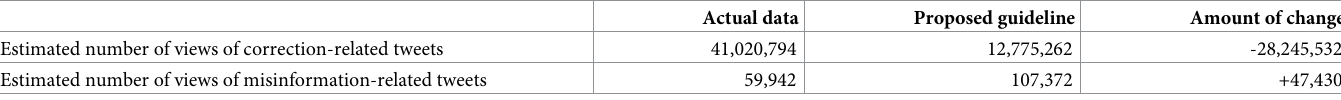
Table 10. Comparison of the estimated number of